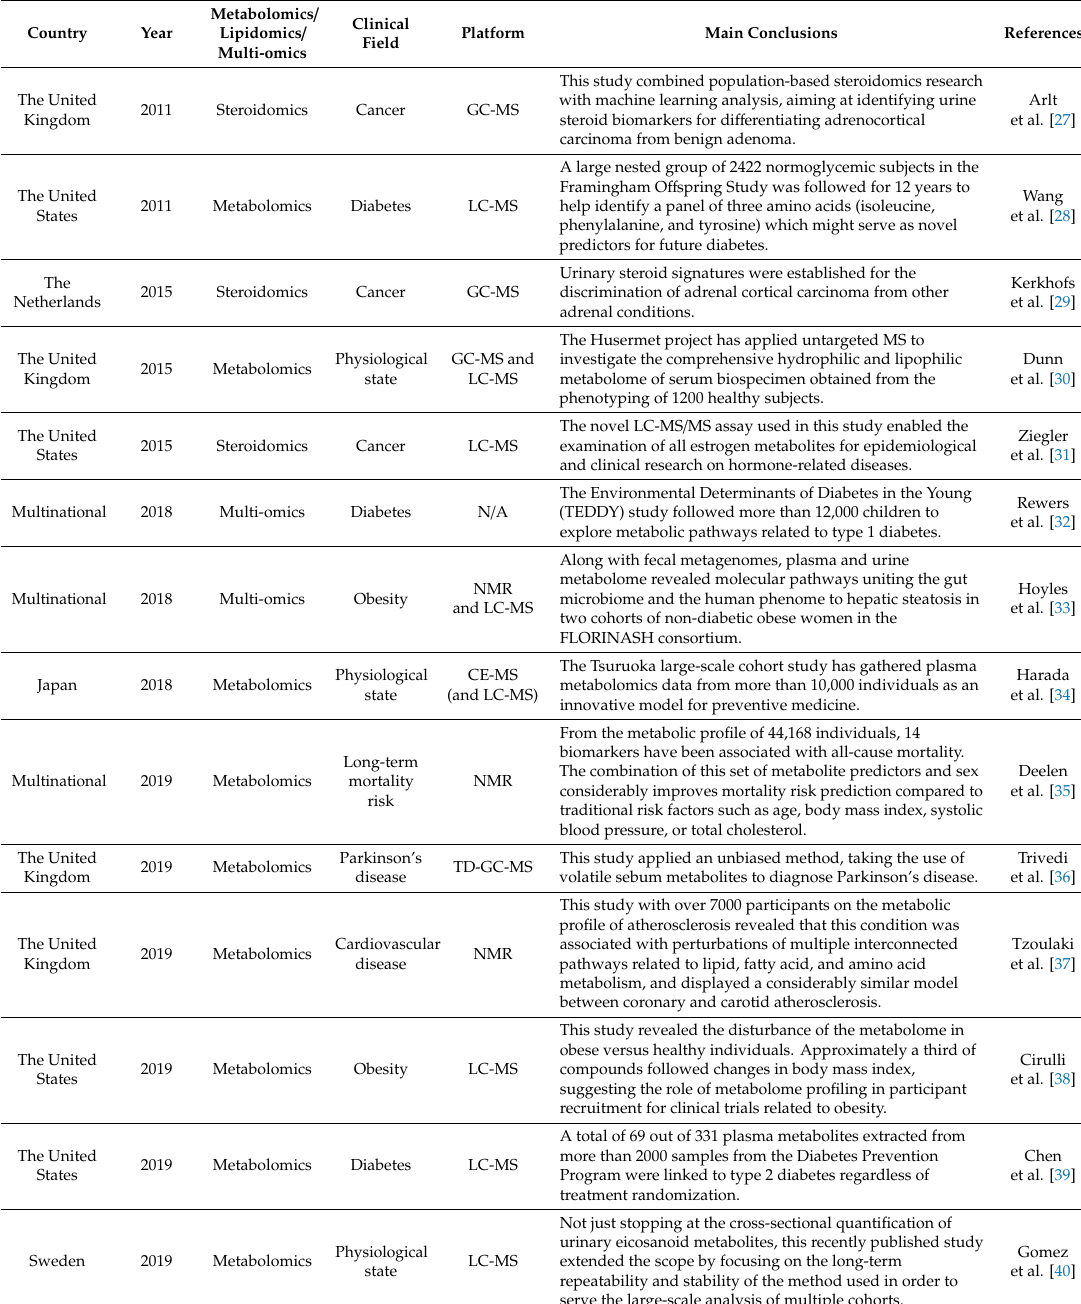
Table 1. Recent representative achievements of metabolomics in public health and clinical